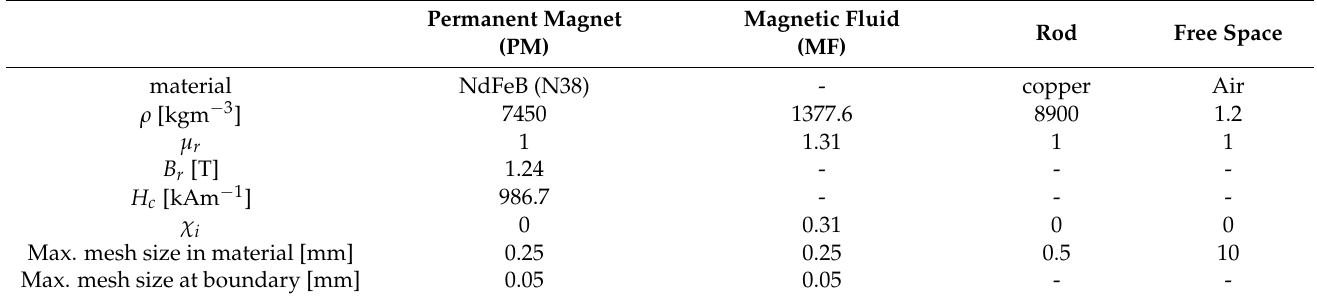
Table 1. Values of the parameters used with the model 1